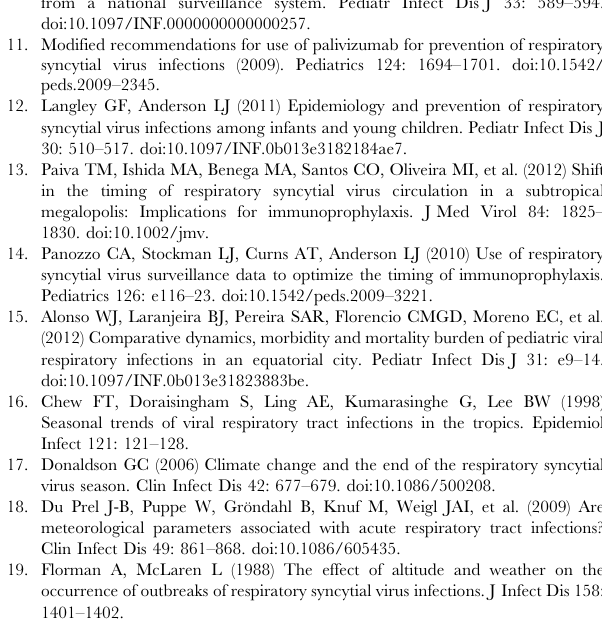
S3 Table Stepwise multivariate regression of RSV timing in 50 US states and District of Columbia. Two indicators of timing are considered as outcome: phase extracted from the 1-year component of reconstructed wavelet decomposi- tion (average weekly phase difference with Florida; see methods) and center of gravity (see earlier description in supplement). The potential explanatory variables are listed in Table 1. p -value for entry , 0.20; p -value for remaining in model , 0.05. S4 Table Correlation among estimated parameters for the transmission dynamic model. S5 Table Comparison of baseline transmission dynam- ic model to model with the transmission rate directly proportional to PET. Log-likelihood of model fit to the laboratory report data from 38 states using sinusoidal seasonal forcing versus modeling the transmission rate as directly proportional to weekly variations in PET. S6 Table Comparison of baseline transmission dynam- ic model to model including school-term forcing. Log- likelihood of transmission dynamic model fit to hospitalization data from 10 states using sinusoidal seasonal forcing alone versus including both school-term and sinusoidal seasonal forcing of the transmission rate. S7 Table Time trends in climate variables for the 50 US states plus District of Columbia, 1994-2004 based on